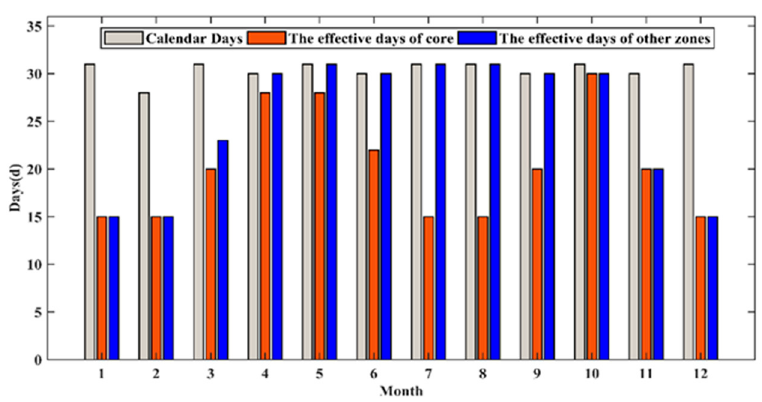
Figure 11. Elevation of each period of the optimal and initial plan.